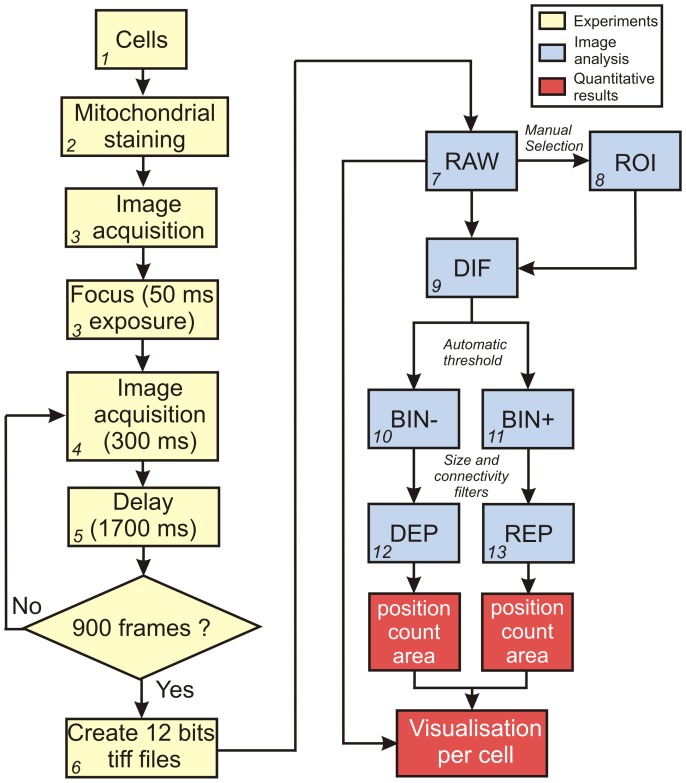
Combined experimental and computational strategy for quantitative spatiotemporal analysis of ΔΨ flickering.Flow scheme visualizing the sequential experimental strategy (yellow), image processing and quantification (blue) and the quantitation and visualization of numerical results (red). Additional details regarding this strategy are provided in the results section.